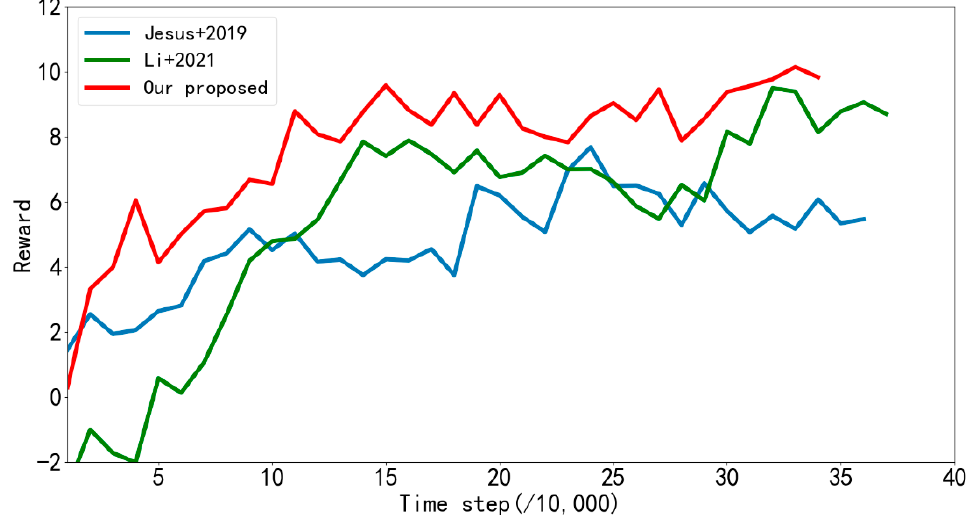
Figure 15. Average reward returned by references [32,33] and our proposed algorithm every 10,000 steps during training in simulation Figure 6b. Table 10. Comparison of training time and steps of each algorithm in simulation Figure